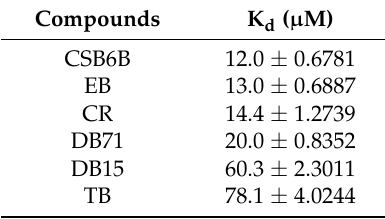
Table 1. Dissociation constant (K D ) upon binding to ubiquitin of different compounds.